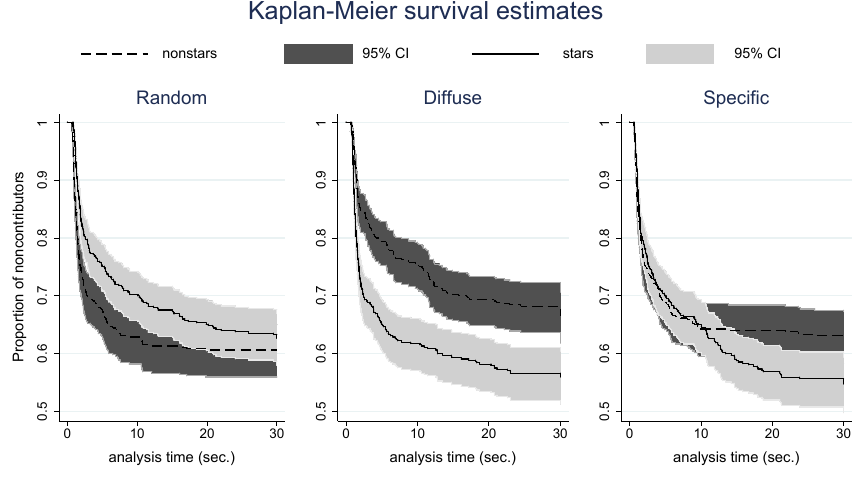
Figure 3: Kaplan–Meier survival estimates of noncontribution by status group and treatment (failure =